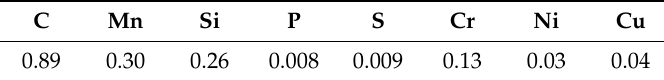
Table 1. Chemical composition of CT90 steel used